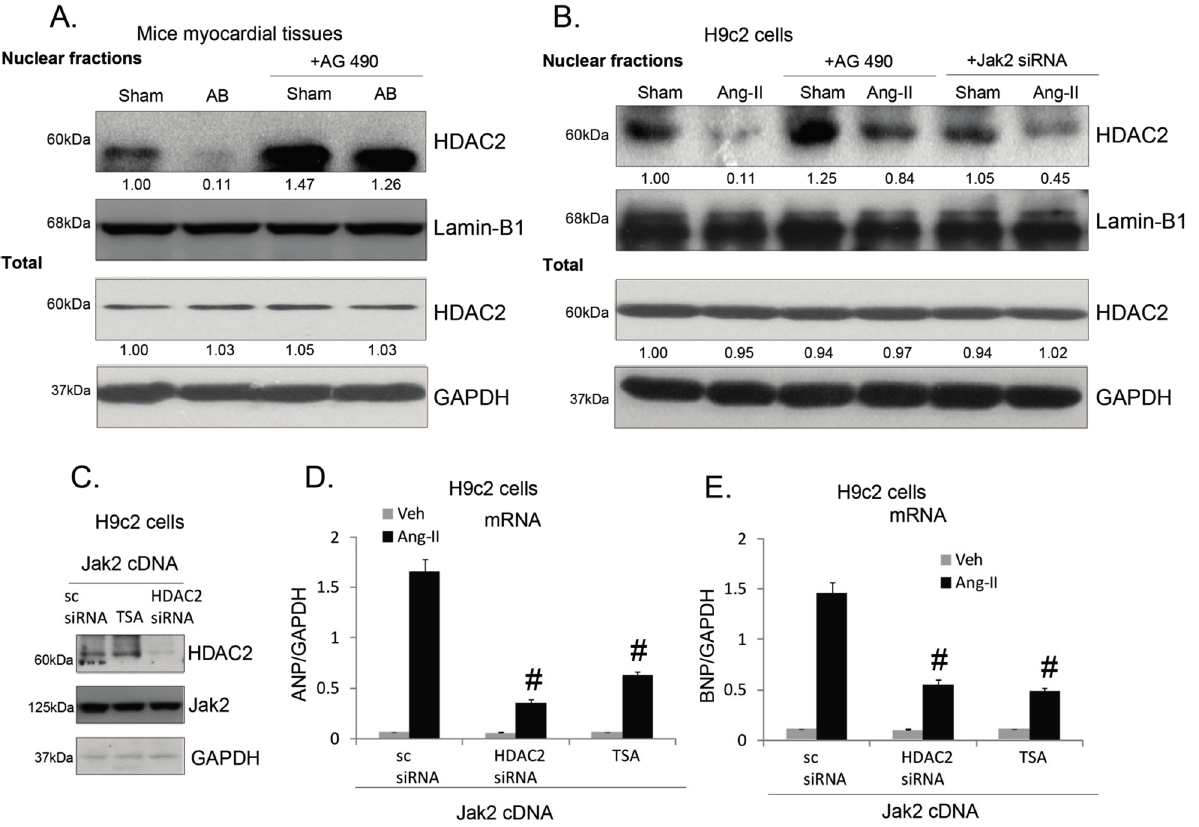
Figure 4. Jak2 is required for HDAC2 nuclear exportation-induced by pressure overload and Ang-II. Nuclear HDAC2 and Lamin-B1 expressions in myocardial tissue of mice subjected to AB or sham operations for two weeks, with or without AG-490 (1 mg/kg body weight per day) or TSA (0.6 mg/kg body weight per day), were tested by Western blots, total HDAC2 and GAPDH expressions were also tested ( A ); H9c2 cells were pretreated with AG-490 (10 μ M, 1 h) or Jak2 siRNA (100 nM, 48 h), followed by Ang-II (1 μ M) stimulation for 12 h, nuclear HDAC2 and Lamin-B1 expressions were tested, total HDAC2 and GAPDH expressions were also tested ( B ); Stable H9c2 cells over-expressing Jak2 were transfected with scramble siRNA (sc-siRNA) or HDAC2 siRNA (100 nM each, 48 h), cells were further treated with Ang-II (1 μ M) in the presence or absence of TSA (100 ng/mL) for 24 h, mRNA expressions of ANP / BNP ( vs. GAPDH ) were tested ( D , E , n = 6); protein expressions of HDAC2 , Jak2 and GAPDH were tested by Western blots ( C ); Experiments in this figure were repeated three times with similar results obtained. All data were expressed as means ± SEM. # p < 0.05 vs. Ang-II treatment with sc-siRNA. “Veh” stands for